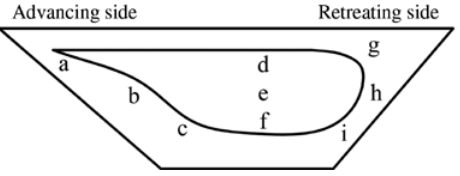
Figure 3: Schematic illustration of the sampling position for the microstructure analysis in Figures 4–6.